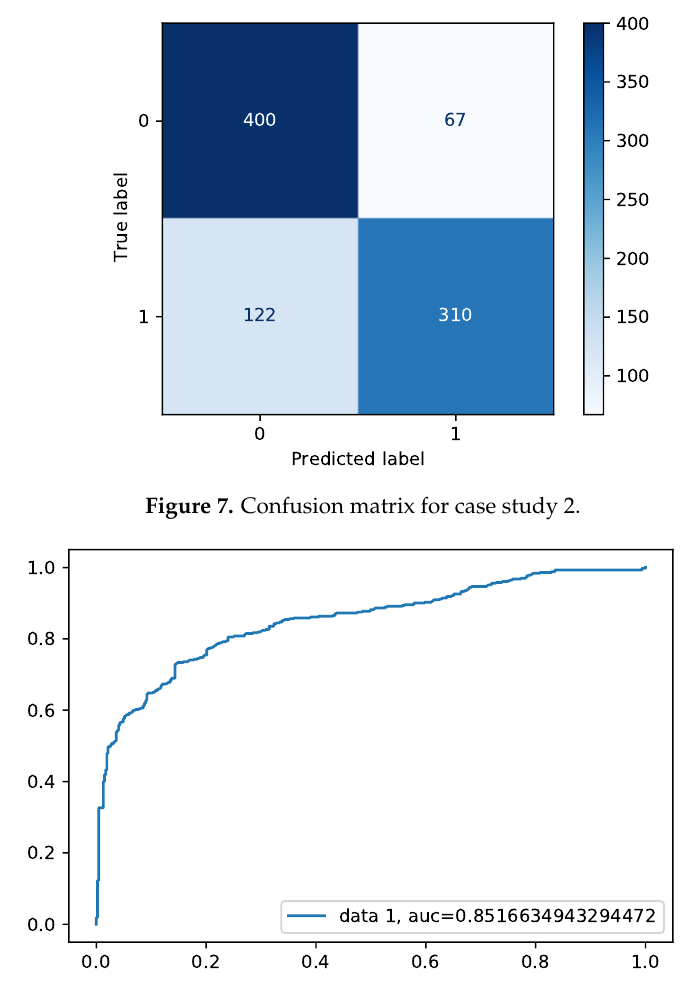
Figure 8. Receiver operating characteristic for case study